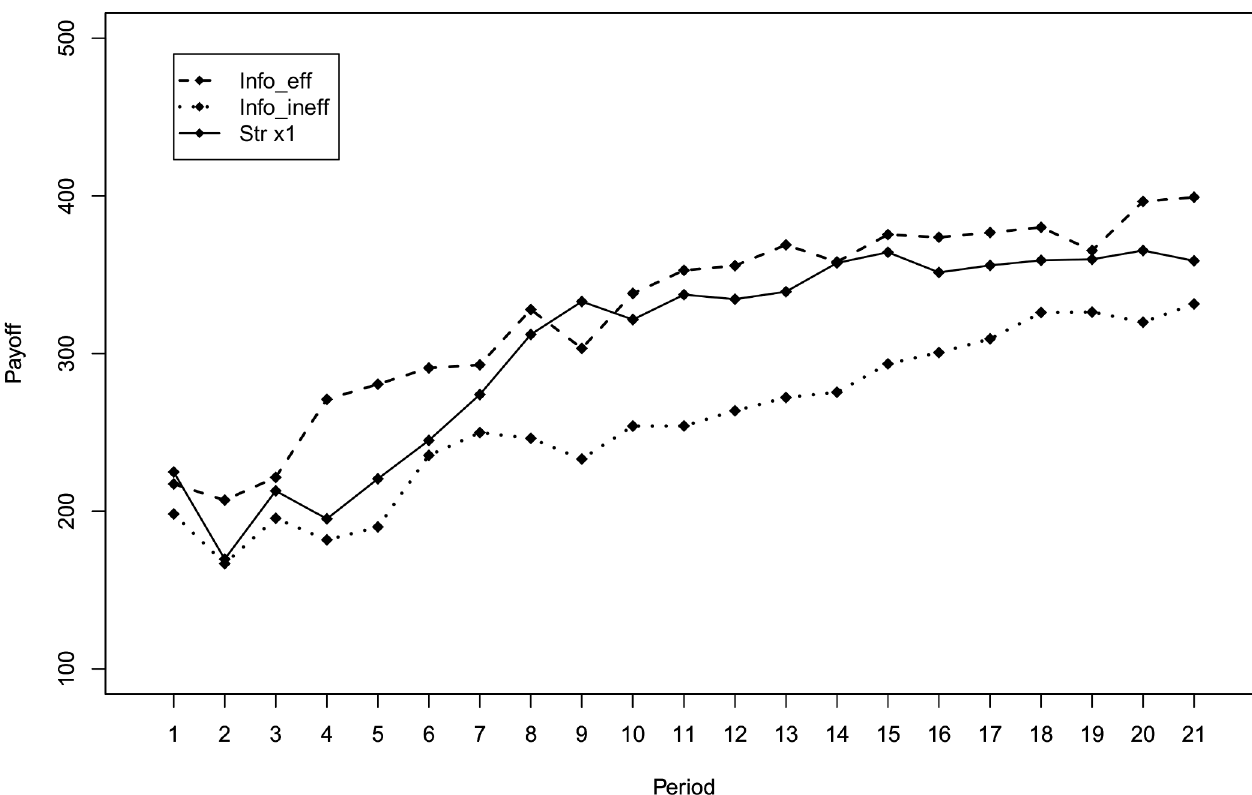
Fig 5. Averagepayoff by round and